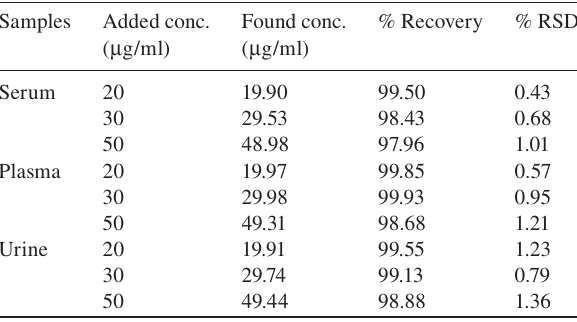
Table 2 Accuracy and precision for the analysis of gatifl oxacin in spiked plasma, serum and urine by differential pulse voltammetry (n = 3). Samples Added